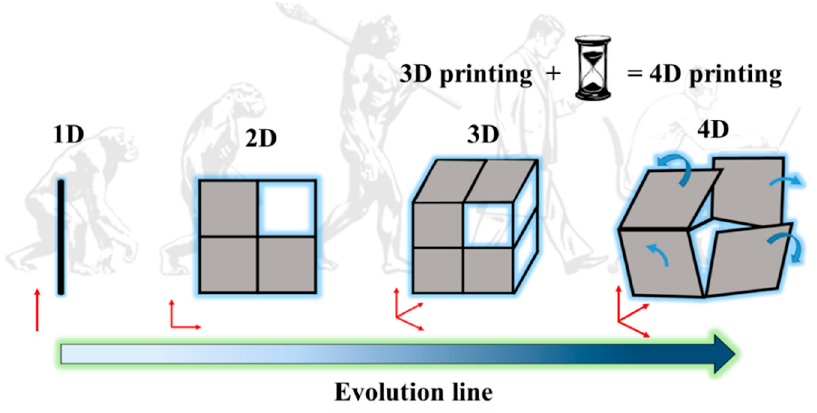
Figure 1. Illustration of the evolution of 1D to 4D printing with time. 4D printing is the addition of time dimension to 3D printing.